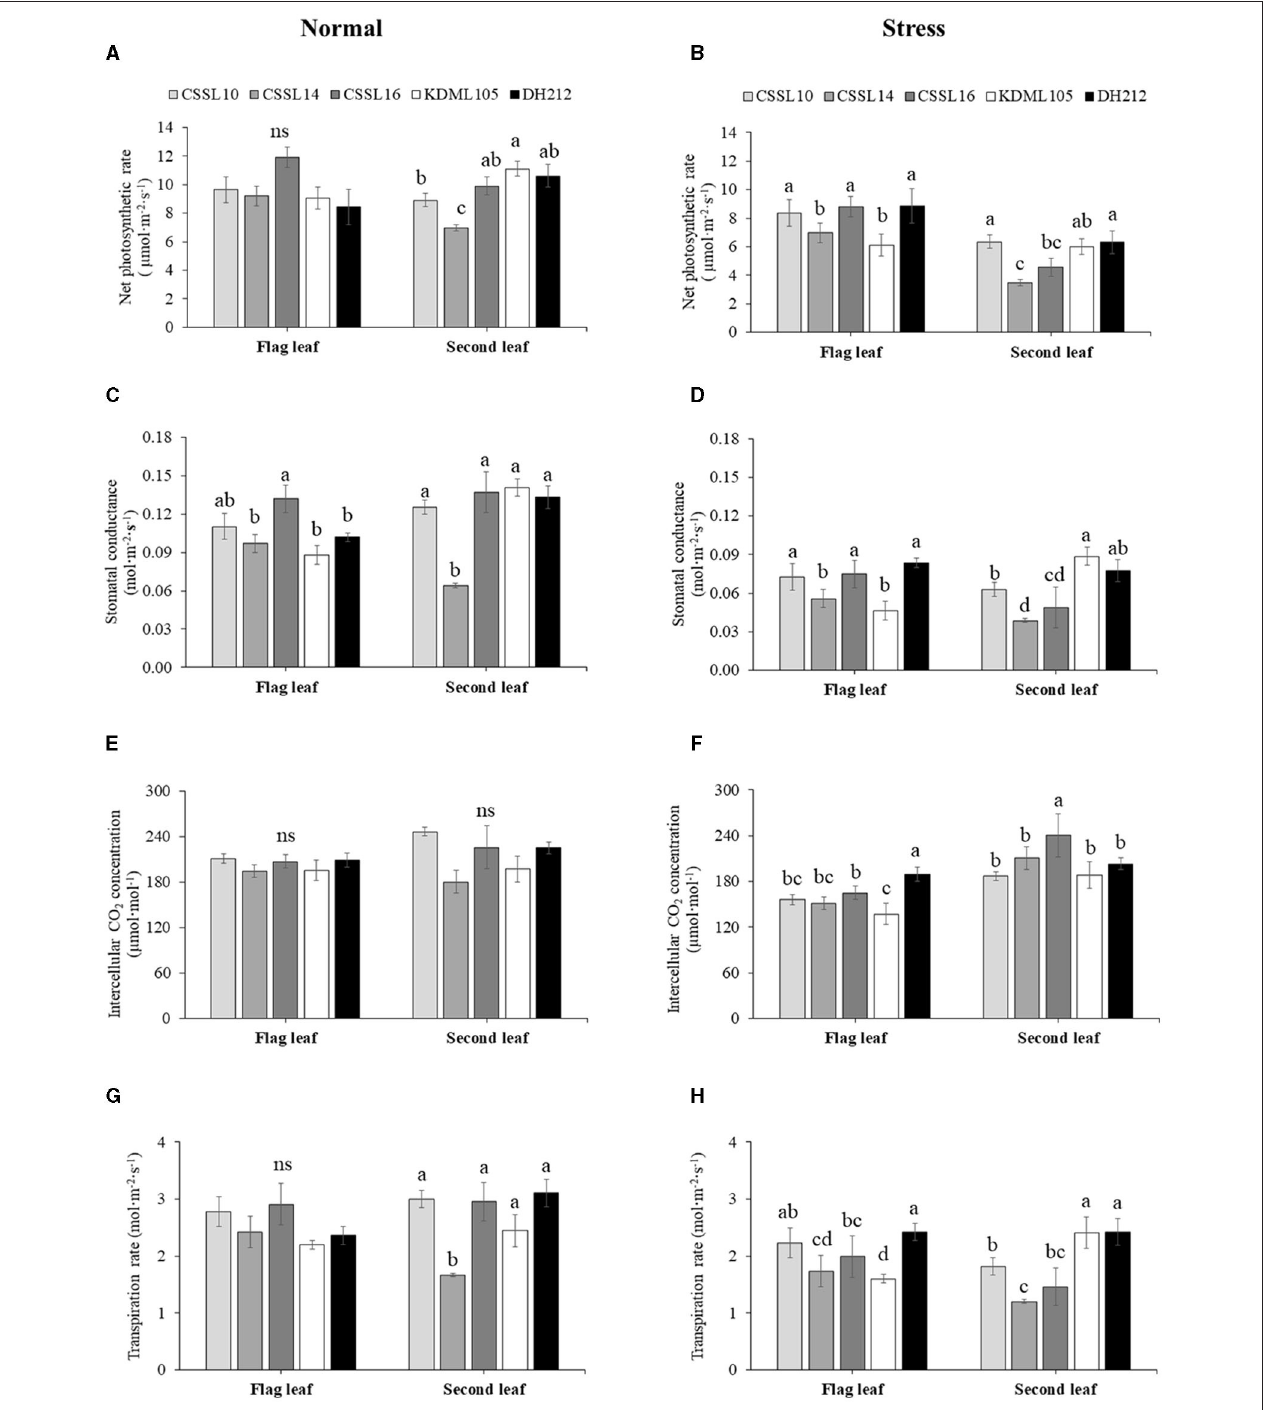
FIGURE 3 | Gas exchange parameters, net photosynthesis rate [Pn, (A,B) ], stomatal conductance [ g s , (C,D) ], internal CO 2 concentration [ Ci , (E,F) ], and transpiration rate (E,G,H) of flag leaves and second leaves of CSSL10, CSSL14, CSSL16, “KDML105,” and DH212 under normal and salt stress conditions. Values are represented as mean ± SE ( n = 4). Different letters above bars indicate significant difference between lines at p < 0.05. “ns” indicates no significant difference.